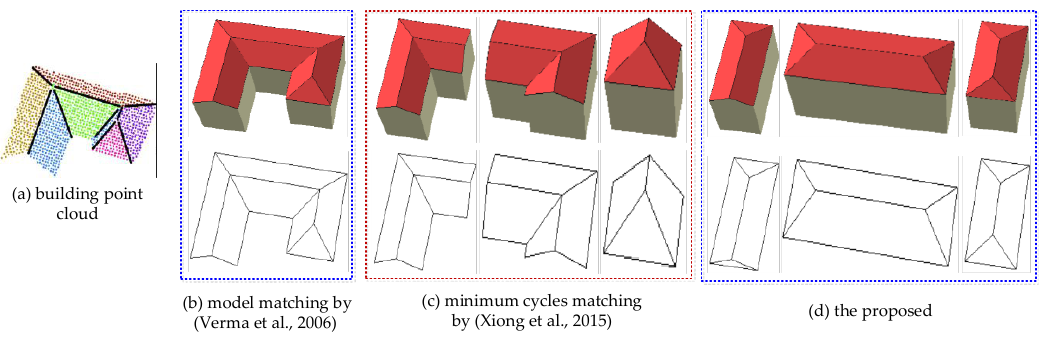
Figure 15. Comparison of the proposed building reconstruction approach with the standard methods. ( a ) The original input building point cloud; ( b ) a whole 3D model by [39]; ( c ) three roof parts